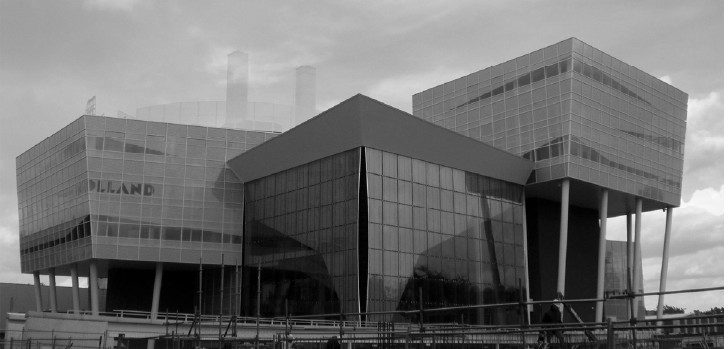
Figure 11: Today’s state of construction.